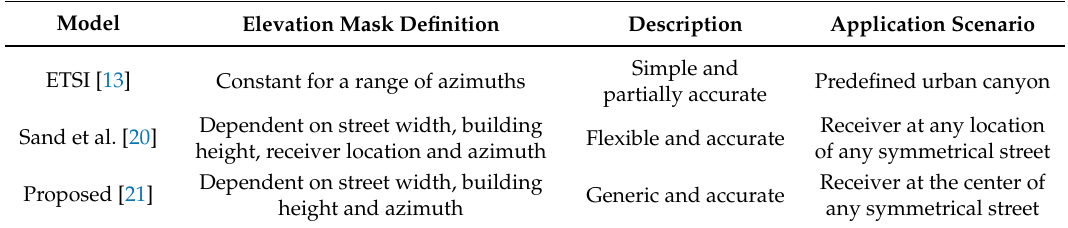
Table 1. GNSS elevation mask models for straight street